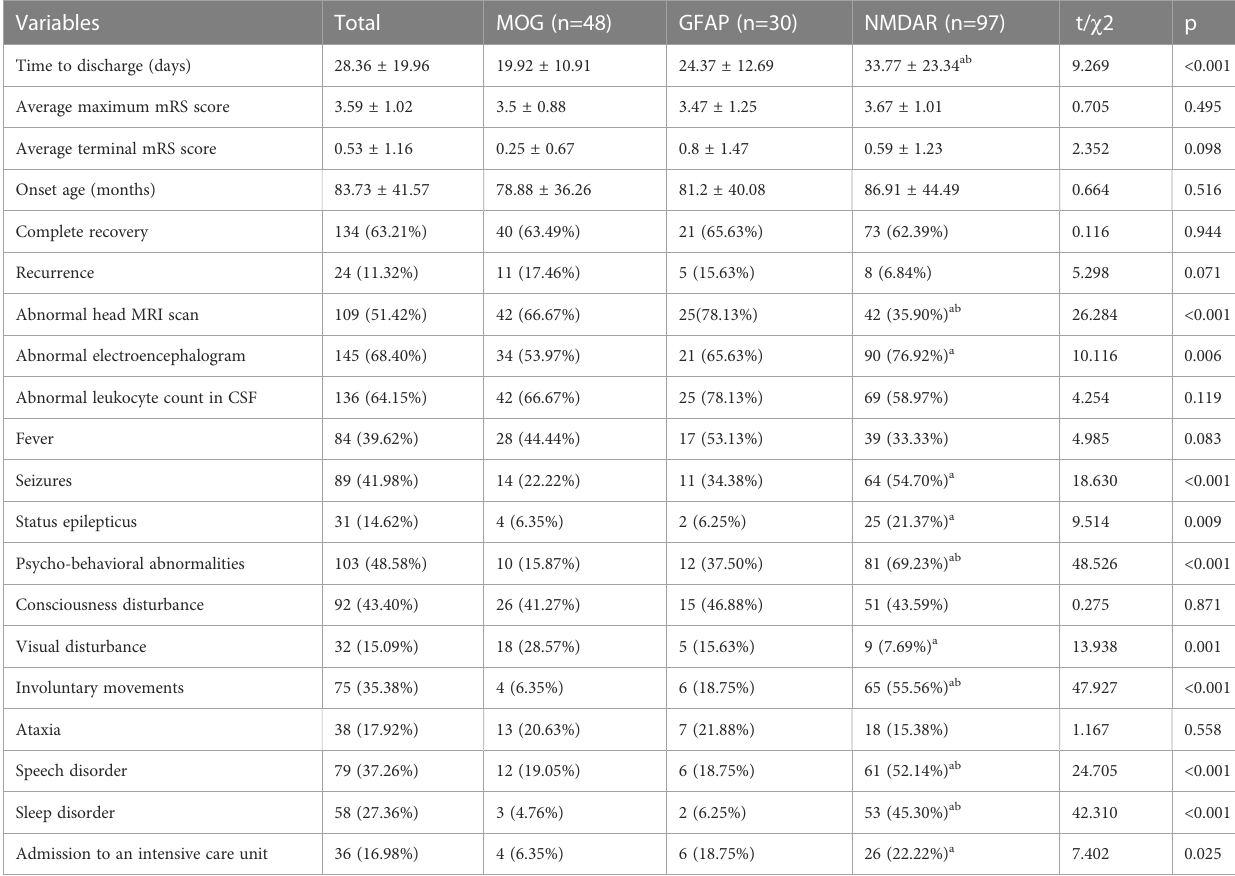
TABLE 4 Comparisons among the MOG group, GFAP group, and NMDAR group.